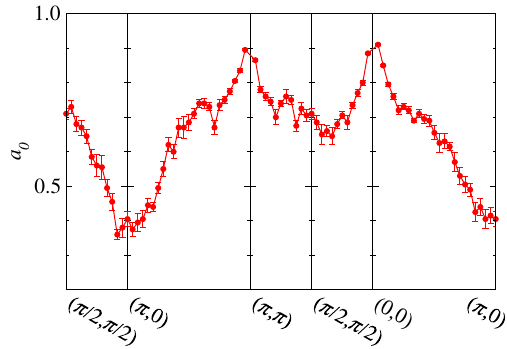
FIG. 10. Relative spectral weight of the single-magnon pole along the representative path in the BZ for the L ¼ 48 Heisenberg system. Error bars were estimated by